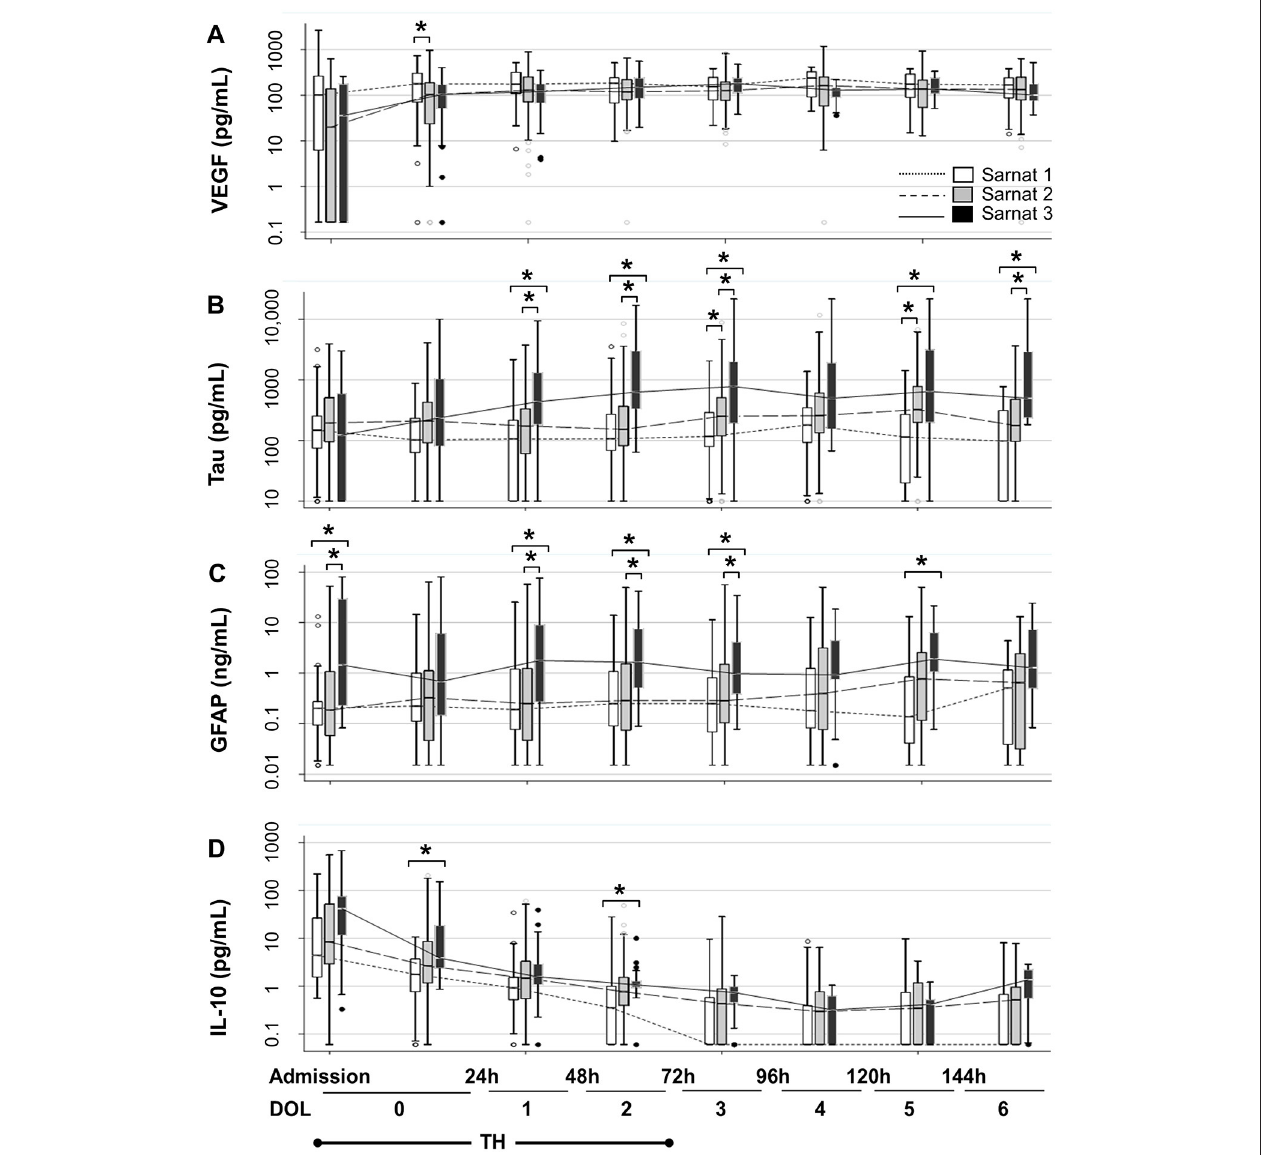
FIGURE 2 | Temporal trajectories of Sarnat score–stratified serum biomarkers. Temporal trajectories of VEGF (A) , tau (B) , GFAP (C) , and IL-10 (D) levels during the first 7 days of life (DOL 0–6) stratified by Sarnat score (1, white; 2, gray, and 3, black) are shown. Two specimens were collected during first 24h of life (DOL 0), the first sample obtained after admission and the one collected in the second 12h of life. Data are represented as box-and-whiskers plot, where the box represents the IQR limited by the 25th and 75th percentiles, with solid line inside the box representing the median. Whiskers are limited by the last data point sitting within 1.5 times the IQR, whereas outliers are represented as circles beyond the boundaries of the whiskers. The biomarker level in a 10-base log scale is shown in the y axis. Time in hours and DOL for all panels are depicted in the bottom of the figure. TH exposure occurred for 72h upon admission to the NICU (for simplification DOL 0–2). * p < 0.05 (KW analysis of variance with Dunn Bonferroni post-hoc analysis). DOL, day of life; GFAP, glial fibrillary acidic protein; IL, interleukin; TH, therapeutic hypothermia; VEGF, vascular endothelial growth